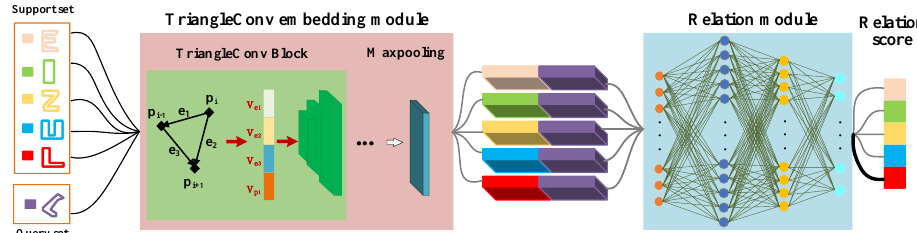
Figure 1. The framework of our relation network model which is mainly composed of the Triangle- Conv embedding module and the relation